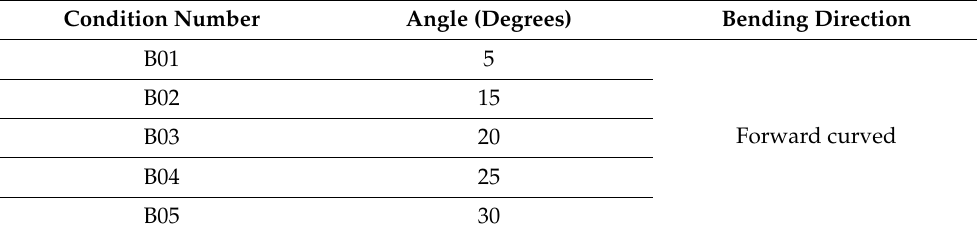
Table 4. Experimental setting for the optimization of blade inclination angle.